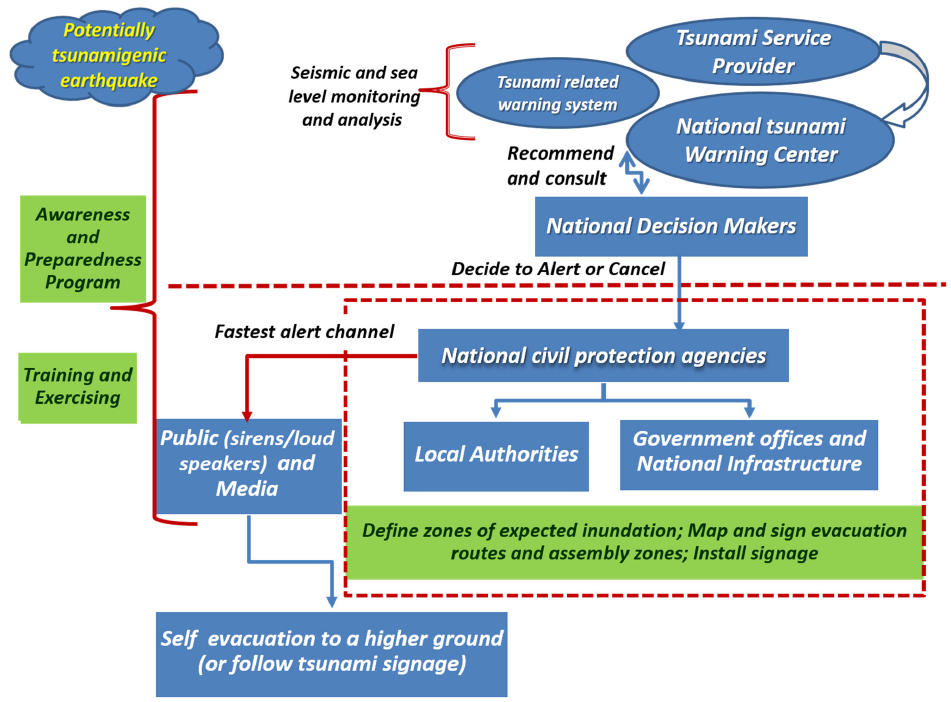
Figure 1. Generic end-to-end organizing architecture and the expected real-time flow of tsunami alerting and